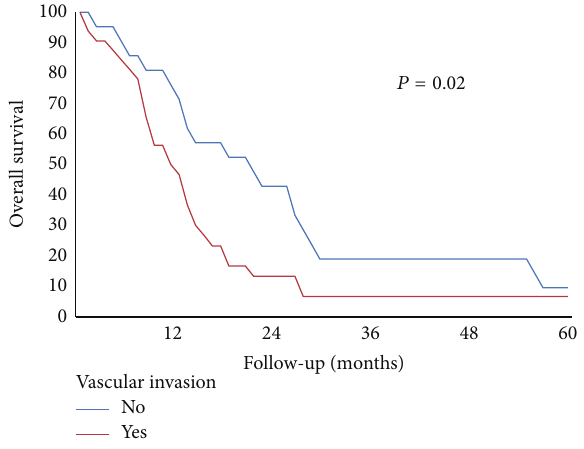
Figure 2: Overall survival in patients who underwent pancreatic resection with vascular resection and histological confirmation of vascular invasion.